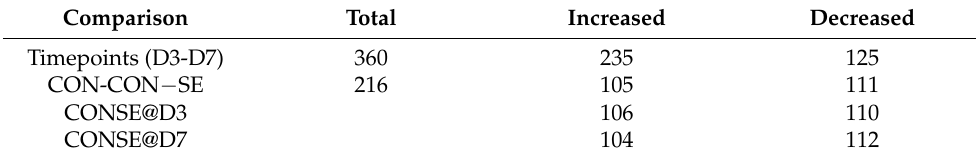
Table 2. Number of differentially abundant proteins identified using ANOVA FDR <0.05.